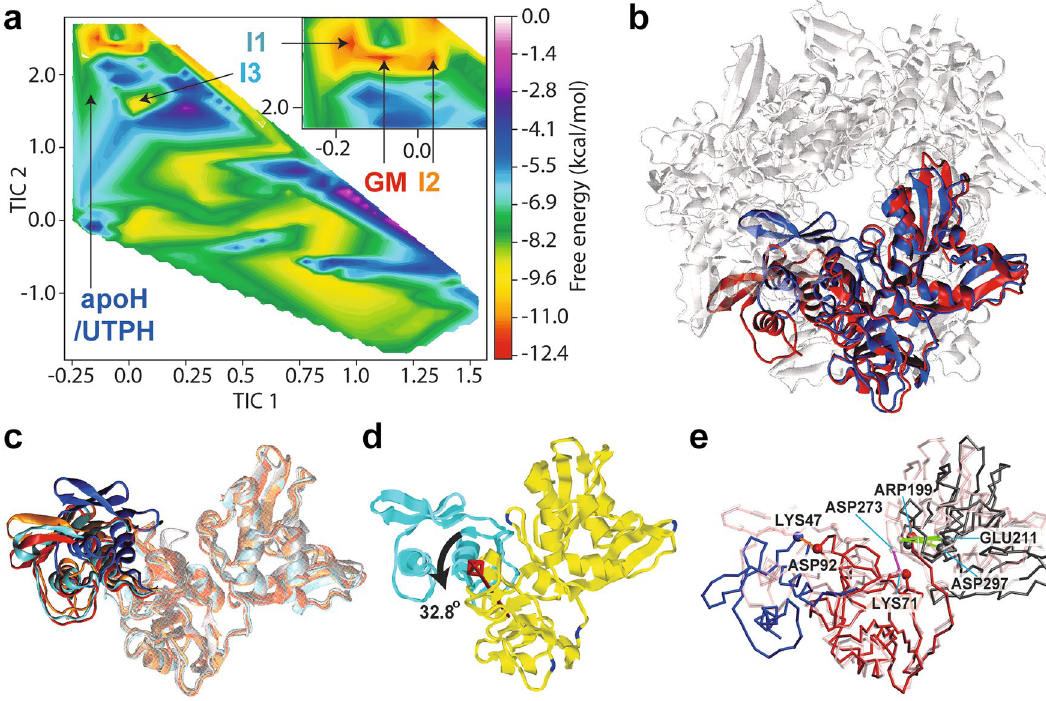
Figure 3. Stable conformation of the Nsp15 monomer. ( a ) Free energy landscape obtained by MSM. The inset shows a close-up view around the global free energy minimum (GM). I1, I2, and I3 represent three intermediates, and apoH indicates the crystal conformation. ( b) Visualization of GM (red) superimposed onto one monomer of apoH (blue) in the hexameric state by best-fitting Mid and C-term domains. ( c ) Comparison of the GM (red), I1 (cyan), I2 (orange), and I3 (blue) conformations superimposed onto the Mid and C-term domains. ( d ) Result of DynDom3D analysis between GM and apoH, shown by the apoH conformation. The red arrow indicates the rotational axis of the dynamic domain (cyan) rotation, which corresponds to N-term domain. ( e ) Inter-domain salt bridges in the GM, apoH, and UTPH conformations. The apoH conformation is shown in white. N-term (blue), Mid (red), and C-term (dark grey) domains of the GM conformation and UTPH conformation (pink) are superimposed on the apoH conformation (white) by best-fitting Mid domain. The green lines connecting ARG199 and LYS205/ASP297 indicate the salt bridges maintained in all the conformations. The magenta lines between LYS71 and ASP273 represent the salt bridge formed in apoH and UTPH, and the orange line between LYS71 and ASP92 shows the salt bridge established solely in GM. ( d ) was created using Rasmol 61